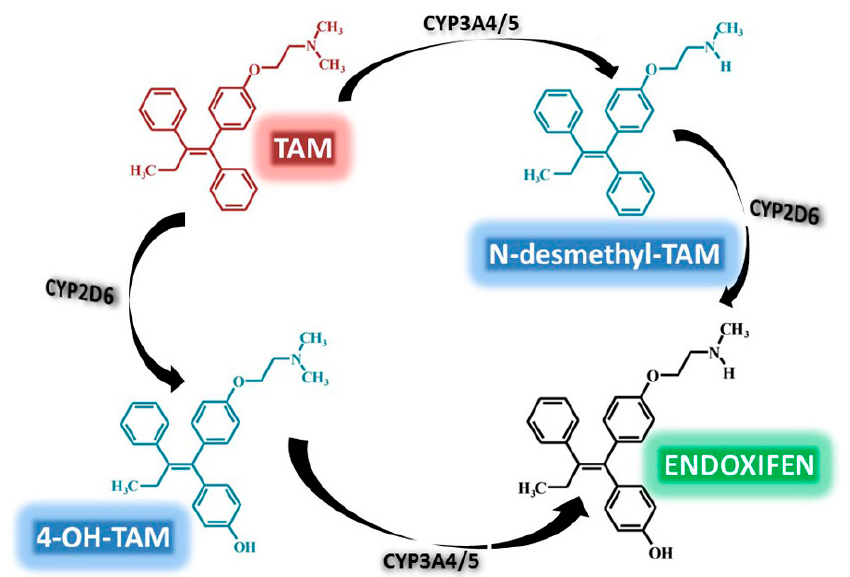
Figure 4. TAM metabolism. TAM is extensively metabolized through biochemical reactions mainly catalyzed by the cytochrome P450 family of enzymes (CYP3A4/5, CYP2D6). Based on Stearns et al. [62].